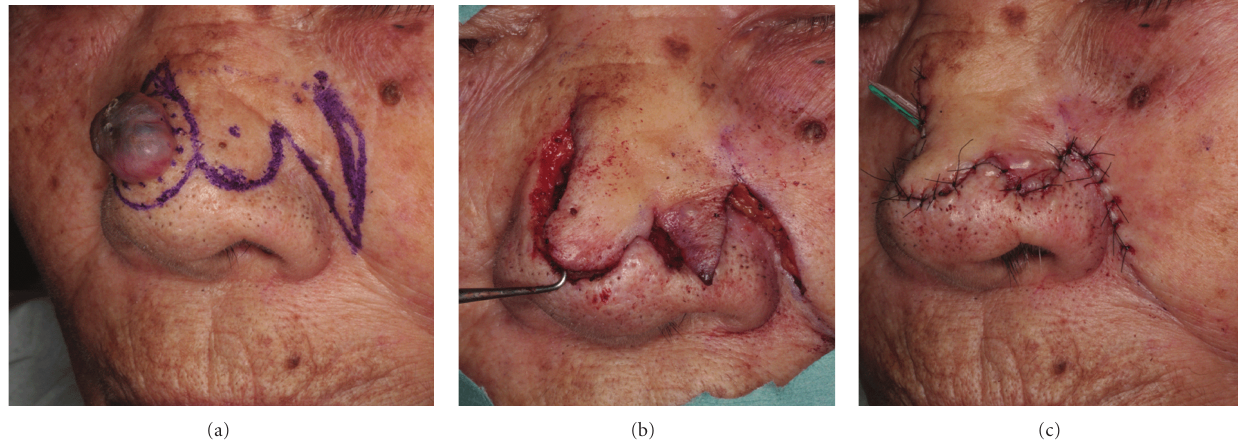
Figure 6: Bilobed flap. (a) Two flaps and surgical margin (5mm) were designed. (b) The primary flap closes the tumor defect, and the secondary flap is used to close the donor site. (c) The donor site of the second lobe is closed primarily.